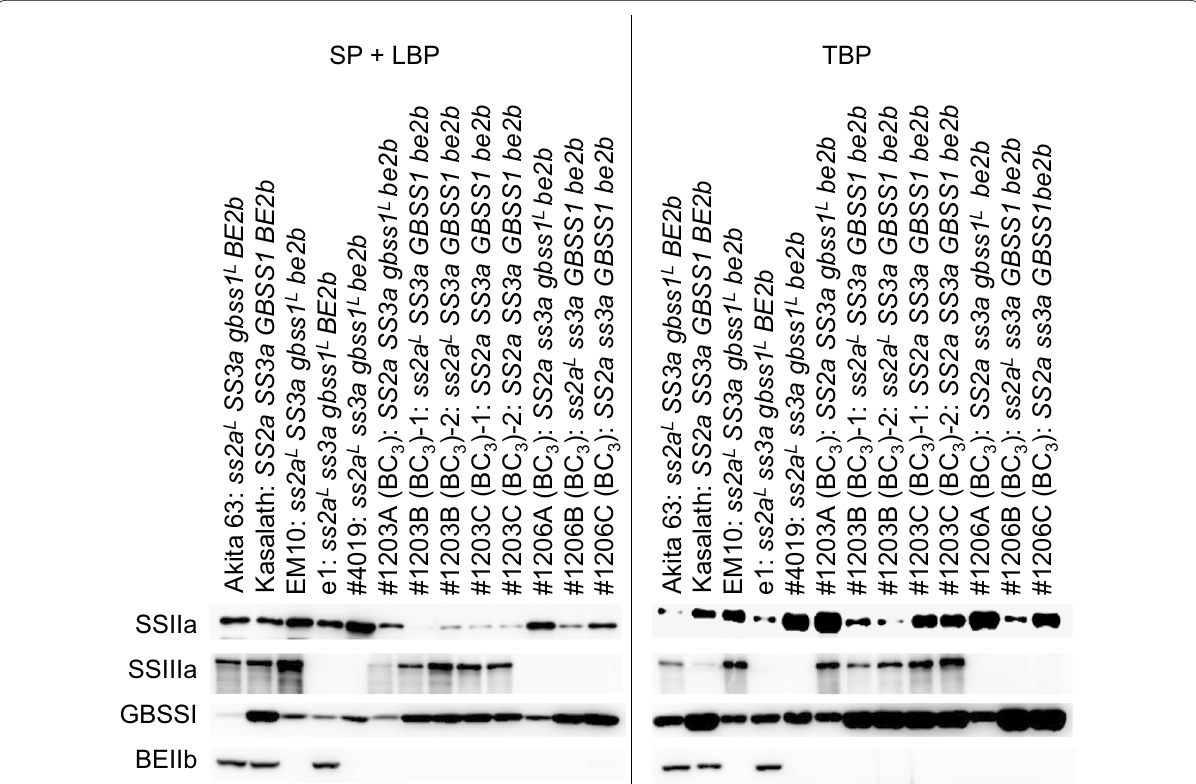
Fig. 1 Western blotting analysis of starch biosynthetic enzymes, SSIIa, SSIIIa, GBSSI, and BEIIb, using mature seed extract. a Soluble protein and proteins loosely bound to the starch granule (SP LBP). b Proteins tightly bound to the starch granule +